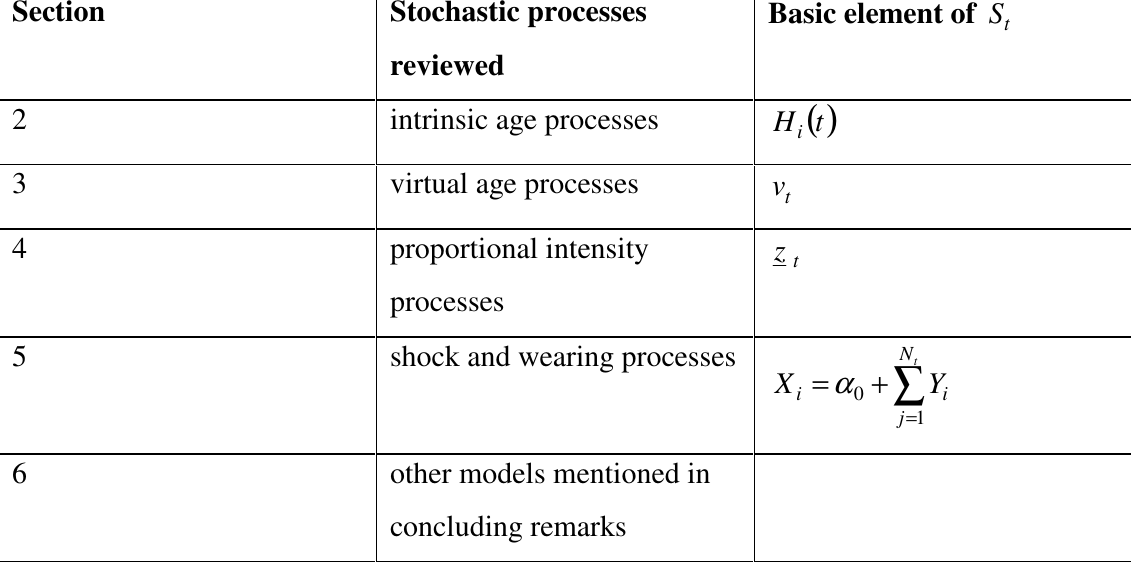
Table 3: Models review